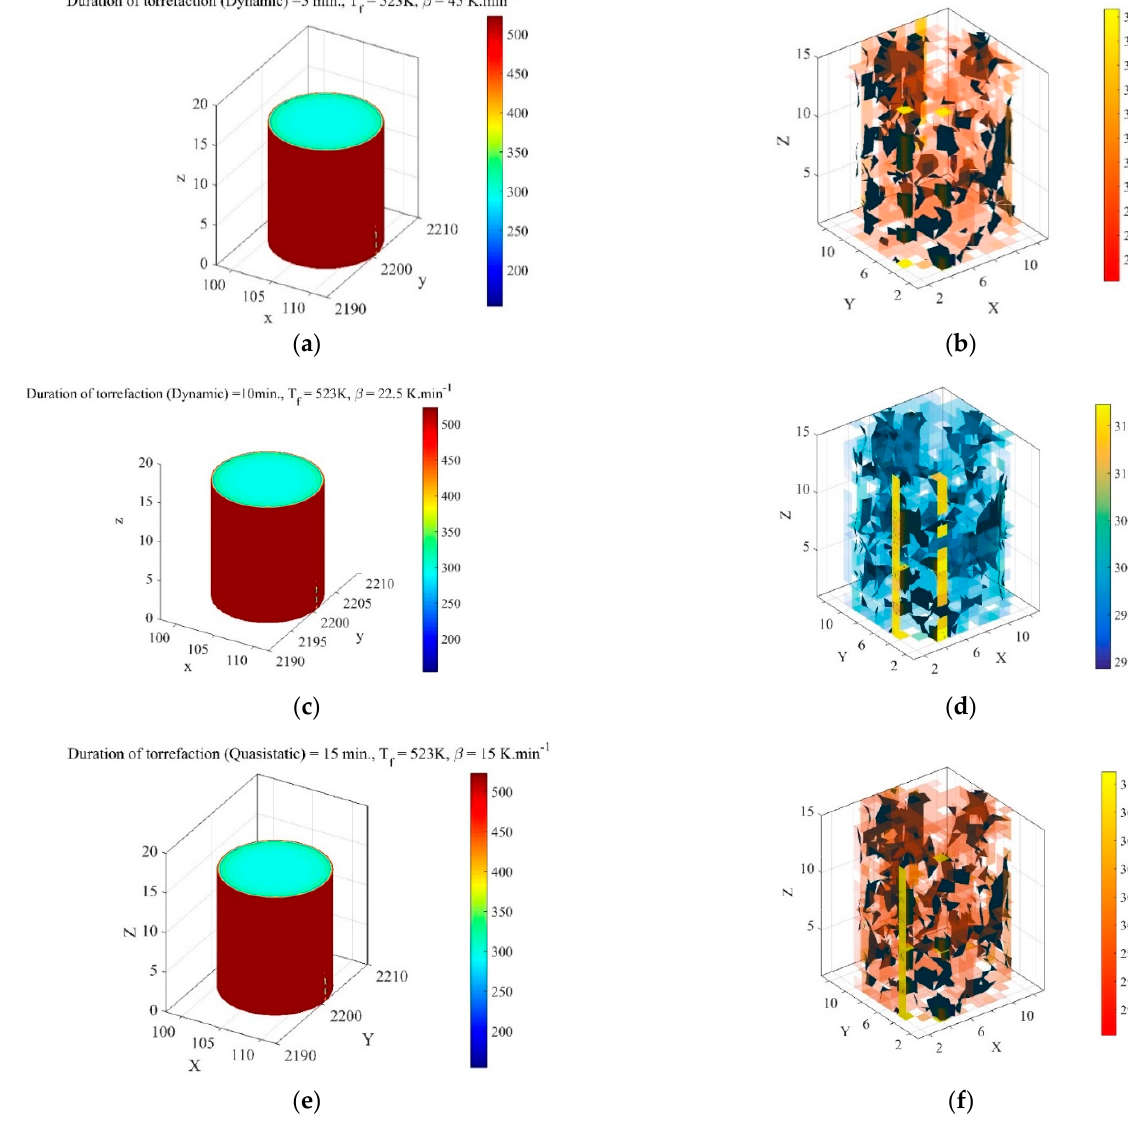
Figure 7. The temperature distribution (dynamic condition) across the biofuel pellet at arbitrarily chosen thermo-fluid properties for torrefaction temperature of 523 K ( a ): mesh points; ( b ): interpolated solution, 5 min; ( c ): mesh points; ( d ): interpolated solution, 10 min; ( e ): mesh points; ( f ): interpolated solution, 15 min (g = 0, q = 1.430 W·m − 2 ·K − 1 , k = 3.056 W·m − 1 ·K − 1 , Re = 798.85, Pr = 0.0001988).